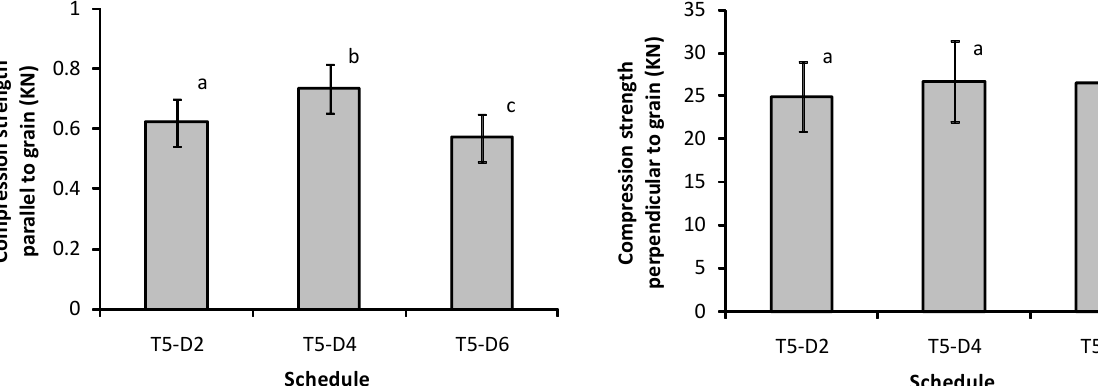
Fig. 1. Compression strength parallel to grain in the dried woods under the three adopted schedules